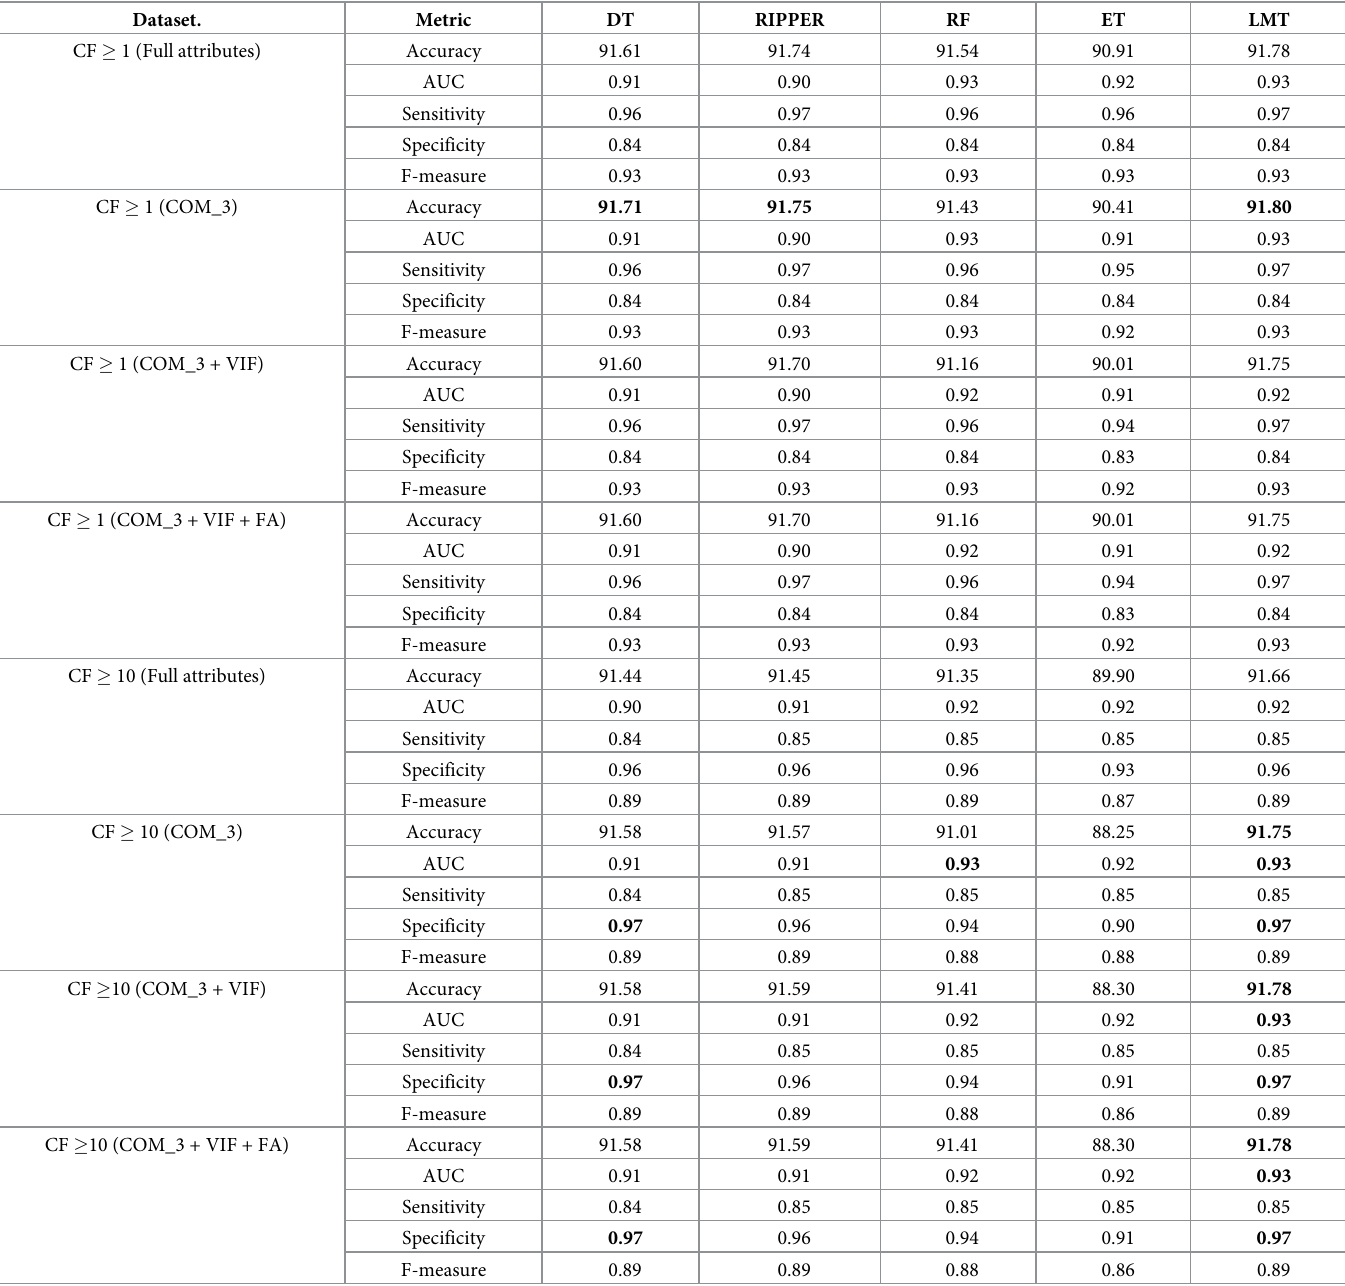
Table 11. Results of COM_3 integrated attributes and then removing collinear attributes.